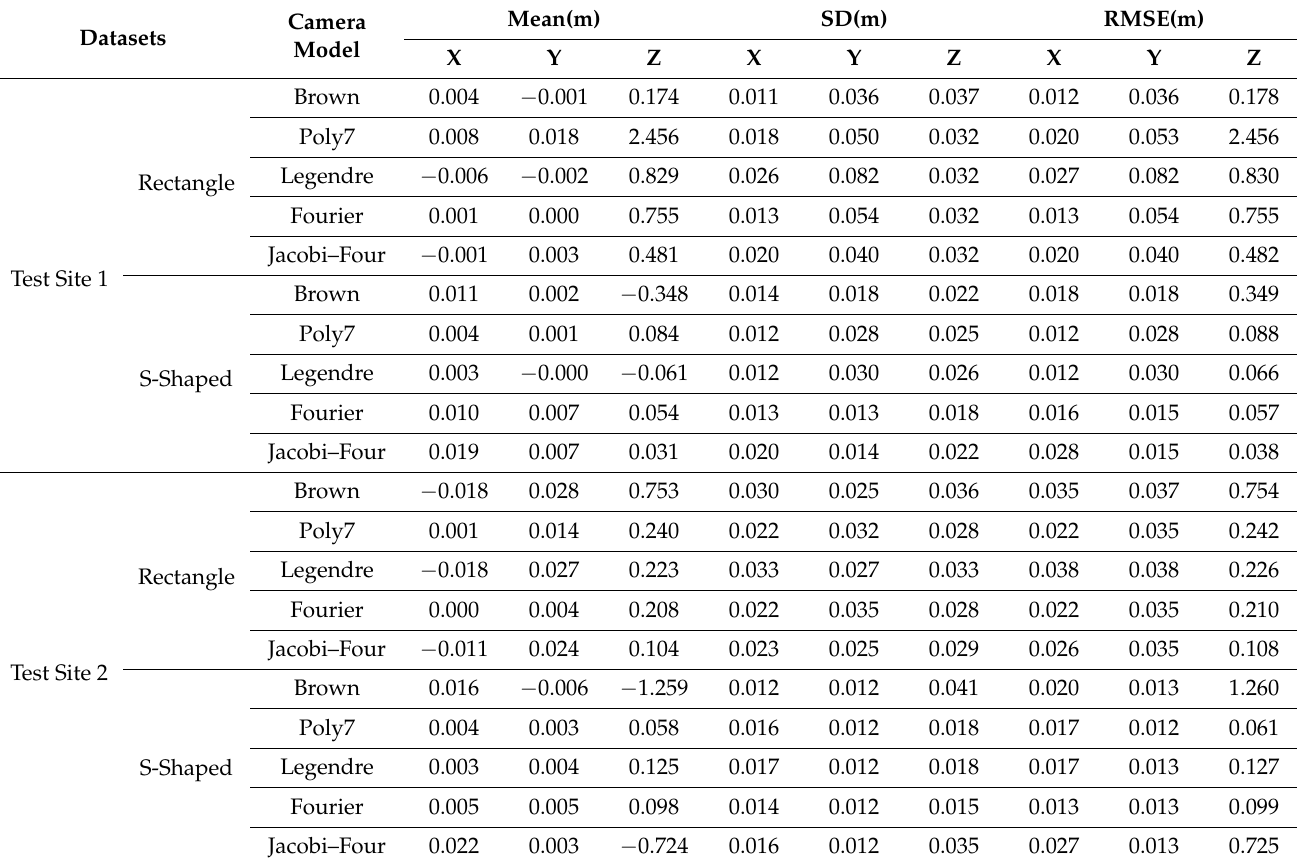
Table 3. Statistical results of self-calibration for different camera distortion